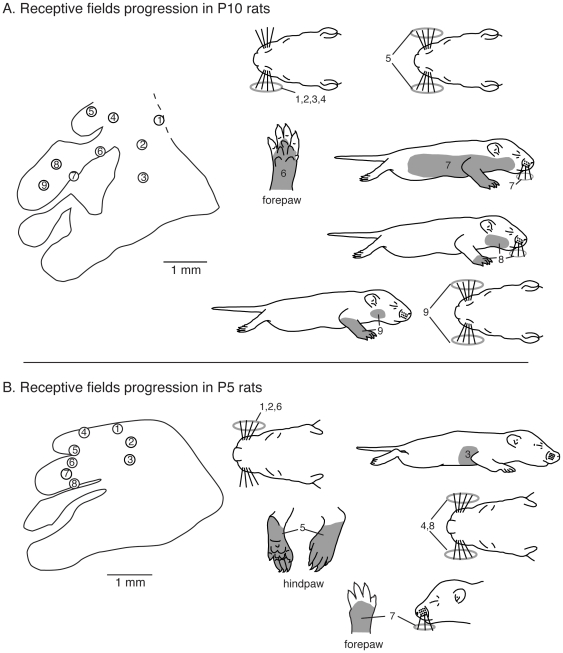
Receptive field progressions in P10 and P5 rats.A) Progressions of recording sites in S1 in a P10 rat (left) and corresponding receptive fields for neurons at those sites (right). In P10 rats, the topographic organization is imprecise. The receptive fields are very large and many receptive fields cover multiple body parts (i.e., sites 7–9). Vibrissae representations are found throughout S1 in inappropriate locations (i.e., sites 1, 2, 4 and 5). As recording sites progress from medial to lateral in the caudal portion of S1 (1–3) corresponding receptive fields were all on the ipsilateral vibrissae. Recording sites in the far medial location (4, 5), in what would be the hindpaw representation in the adult, had receptive fields on the ipsilateral or vibrissae. Recording sites in medial portions of S1 in what would normally be the forepaw representation (6–9) had receptive fields on the forepaw, split receptive fields on the upper body and vibrissae, bilateral vibrissae and face and vibrissae. B) Progressions of recording sites in S1 in a P5 rat (left) and corresponding receptive fields for neurons at those sites (right). In P5 rats there is no apparent topography. Receptive fields are large, and, when present on the limbs, encompass both hairy and glabrous portions of the paws. Receptive fields are also observed on both the contralateral and ipsilateral body parts. Vibrissae representations are prevalent and found throughout S1. As recording sites progress from medial to lateral in the caudal portion of S1 (1–3) corresponding receptive fields move from the contralateral vibrissae to the lateral trunk. Far medial recording sites (4–5) in what would normally be the hindpaw representation had receptive field on the vibrissae, and in one instance the dorsal and ventral hindpaw. More medial recording sites (6–8), in what would normally be the forepaw representation had receptive fields on the contralateral or bilateral vibrissae, and wrist and vibrissae. Compare this figure with the full map of the body illustrated in Figure 1. Conventions as in previous figures.